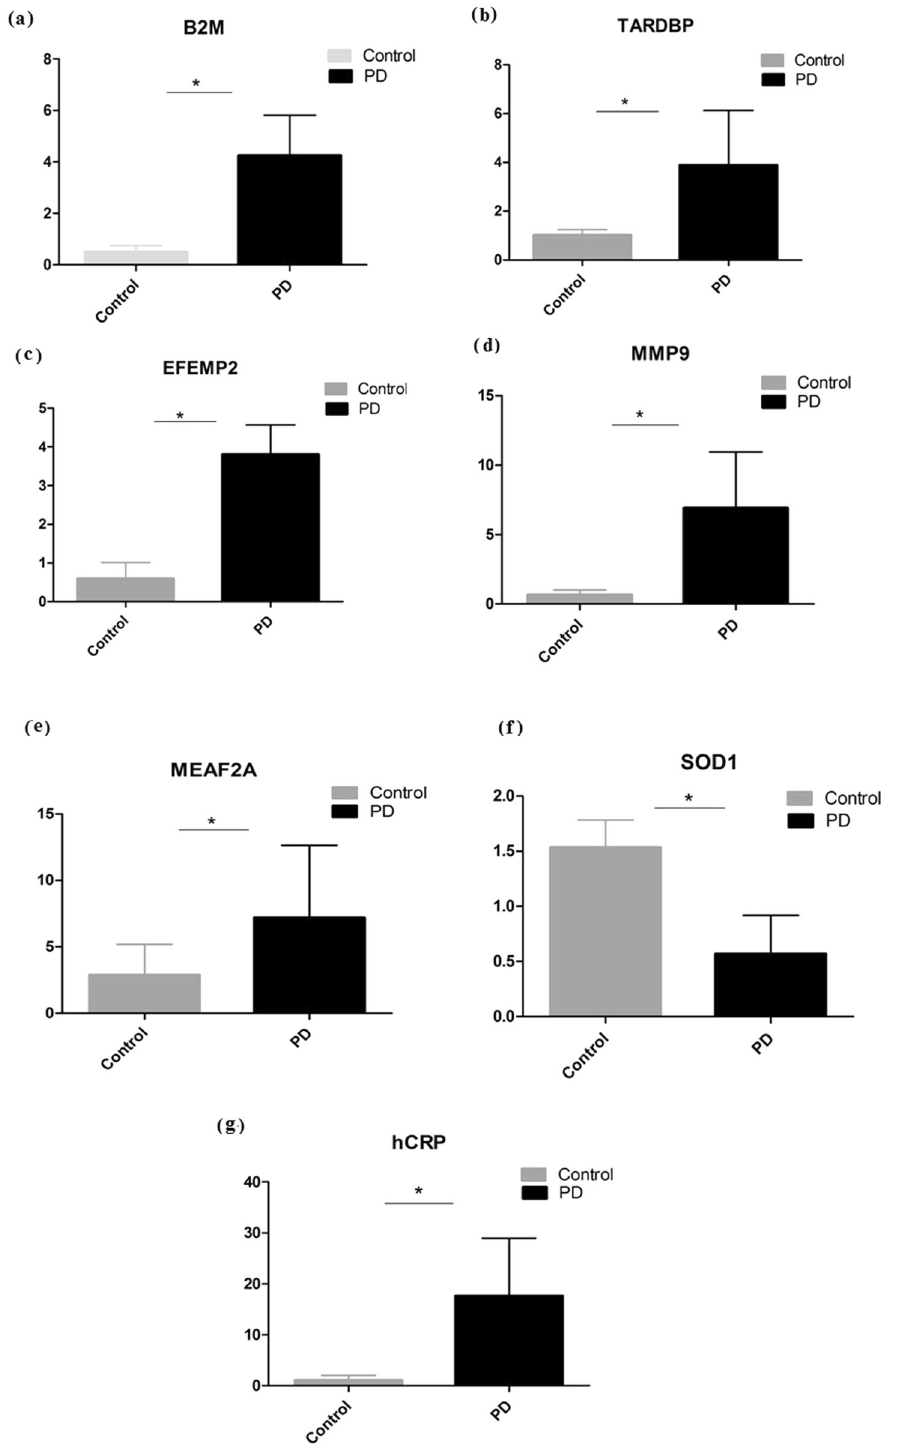
Fig. 4 Quantitative real-time gene expression analysis of hub proteins encoding genes in PBMCs from control vs. PD. a B2M, b TARDBP, c EFEMP2, d MMP9, e MEAF2A relating copper, magnesium, aluminum, calcium, and iron, respectively. The gene expression of f SOD1, and g hsCRP are the markers for PD. Bars represent the Average, standard deviation (SD) with * P value <